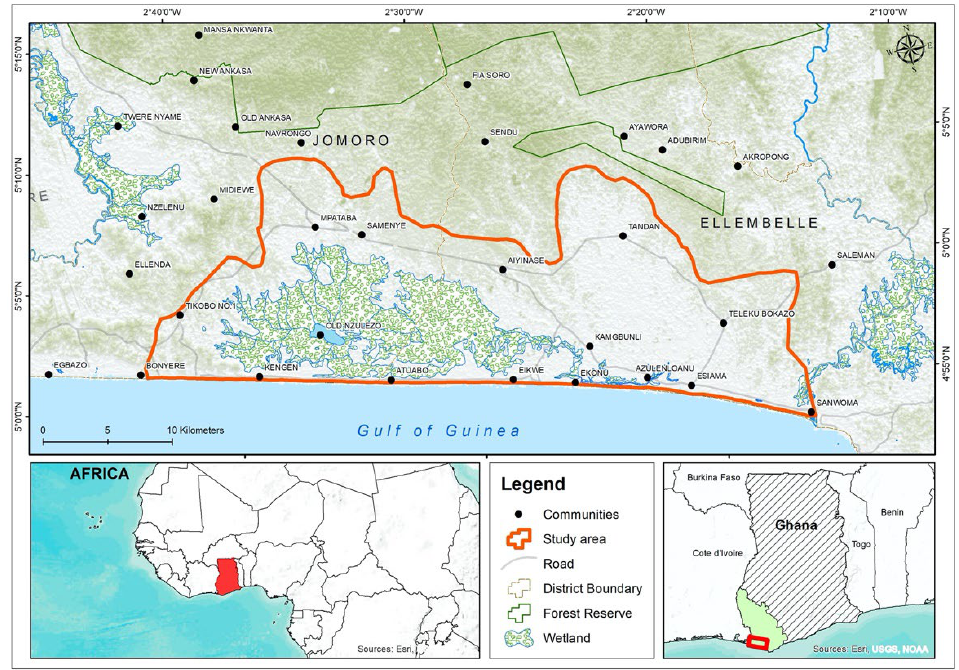
Figure 1. Map of the coastal landscapes of Southwestern Ghana showing the study area .